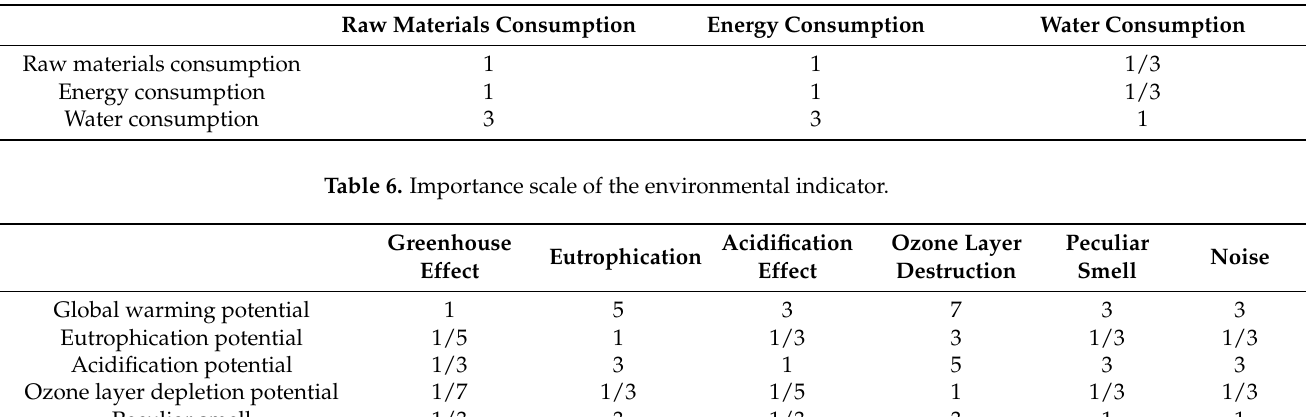
Table 5. Importance scale of the resource indicator.